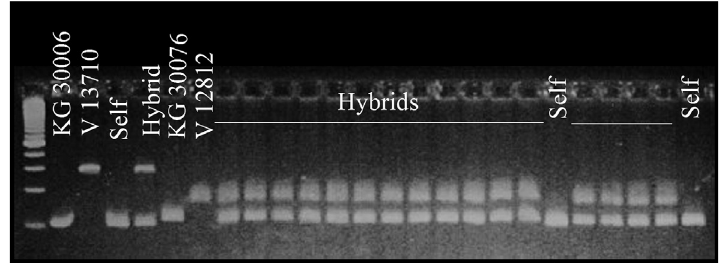
Figure 1 - Combinations between Arachis hoehnei and A. simpsonii and A. ipaënsis and A. villosa and their progeny. Agarose gel, using LEC